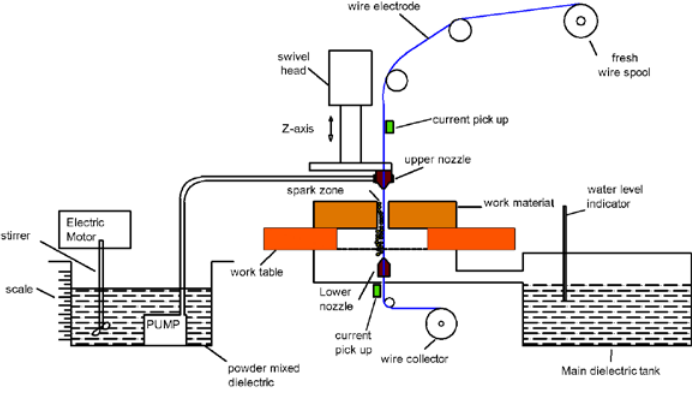
Fig. 2. Experimental setup for Powder Mixed WEDM in present work